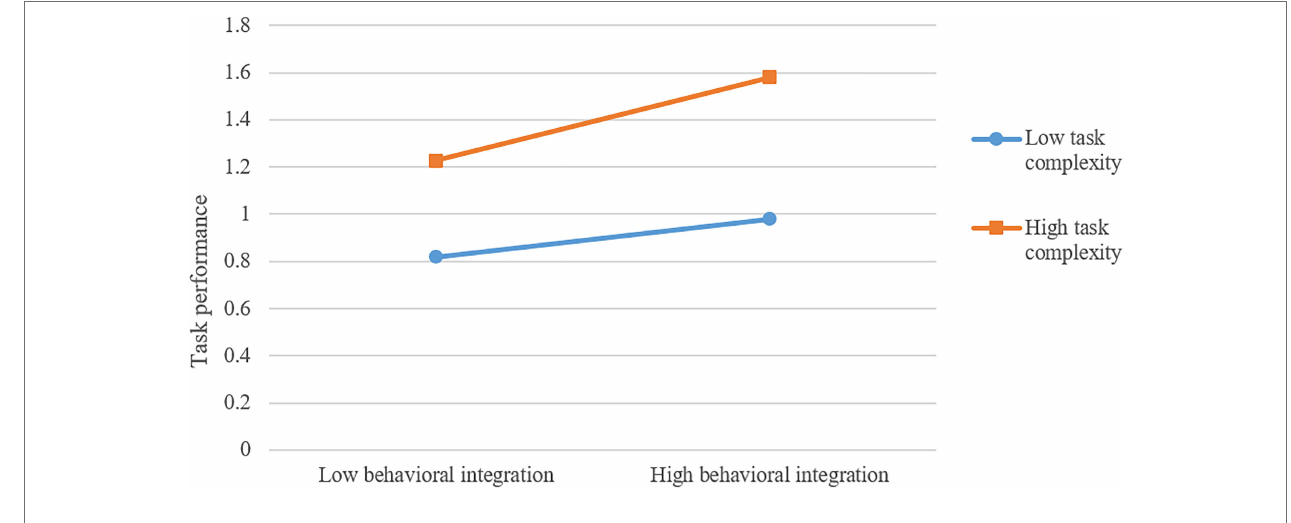
FIGURE 2 | Moderating effect of task complexity.